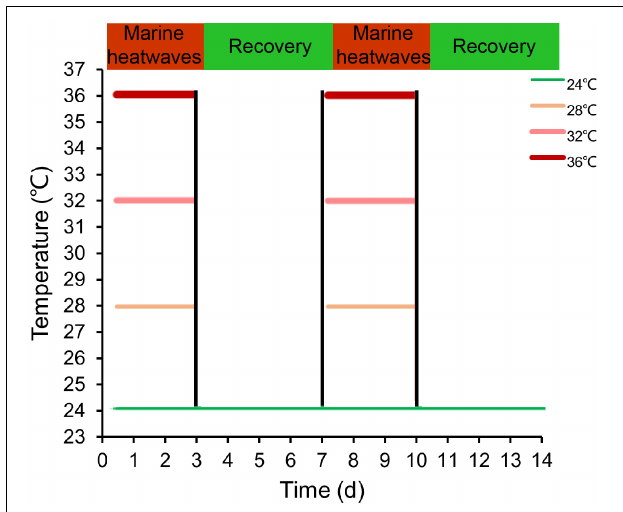
FIGURE 1 | Overview of the experimental design illustrating MHWs scenarios varying in frequency and intensity. Green line indicates the temperature regime designated in the control and color intensity of red lines represents the intensity of temperature regimes designated under MHWs conditions.